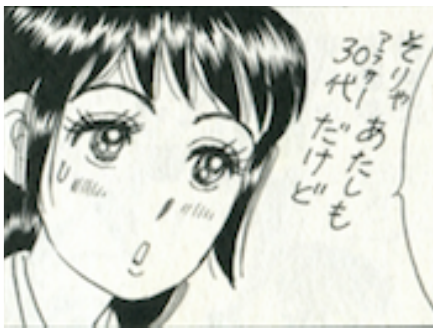
Figure 20. “Well, I am almost thirty after all” (Shimizu 2014, 88). Courtesy of